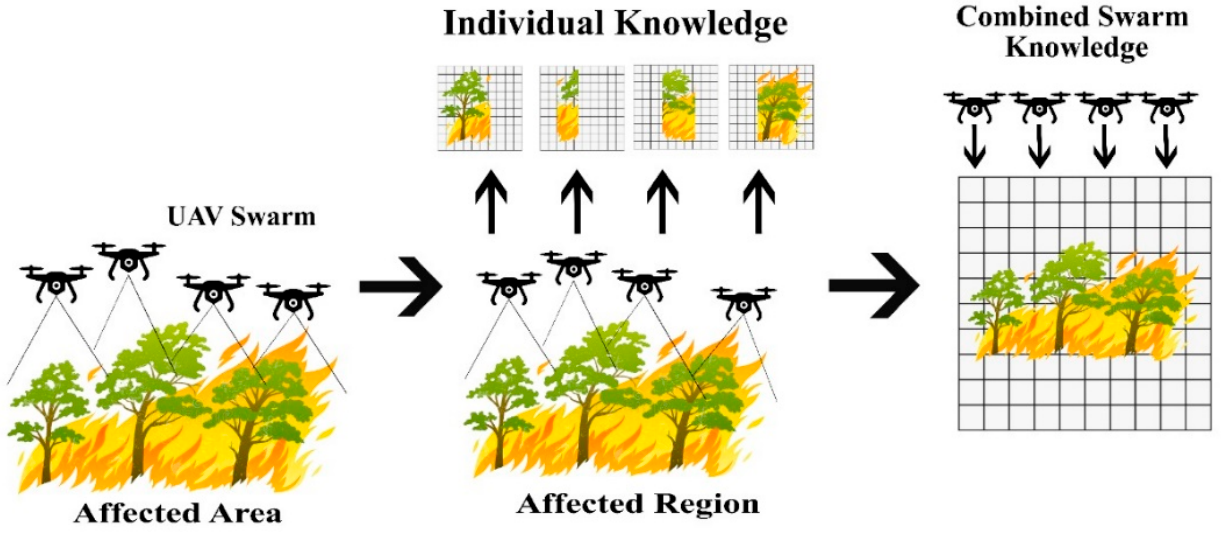
Figure 5. UAV swarm capturing affected region and knowledge sharing mechanism.